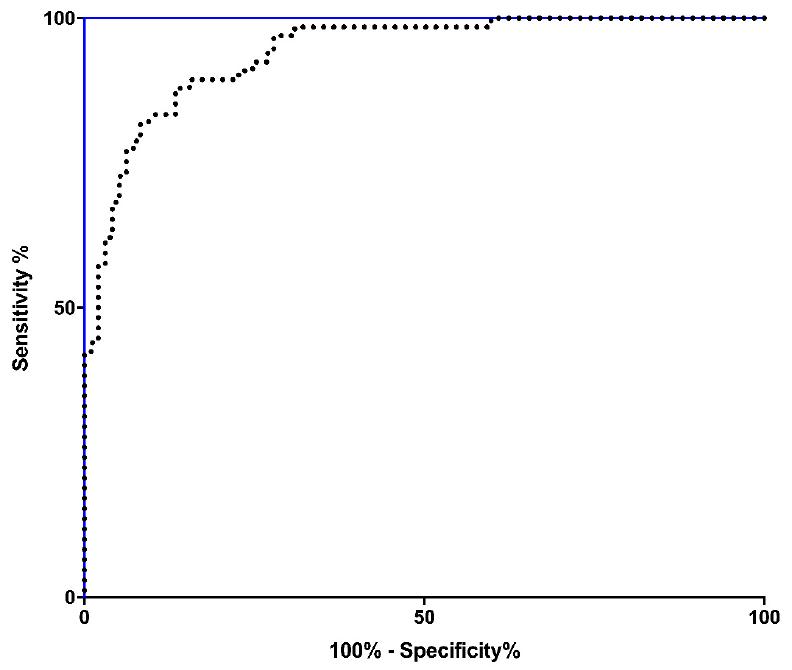
Figure 4. Comparison of the AUROC of the HC/BC ratio calculated on the basis of ebSCr with AUROC of the HC/BC ratio calculated on the basis of mbSCr (gold standard).